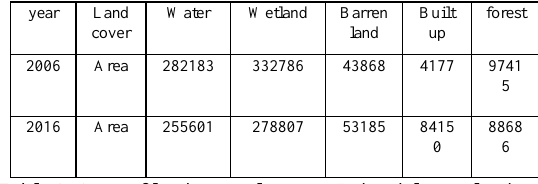
Figure 6: Landcover map of Indus Delta 2006 Classification results for 2016 showed decrease in water body and wetland area while forest and barren land very insignificant changes yet built up area has increased.